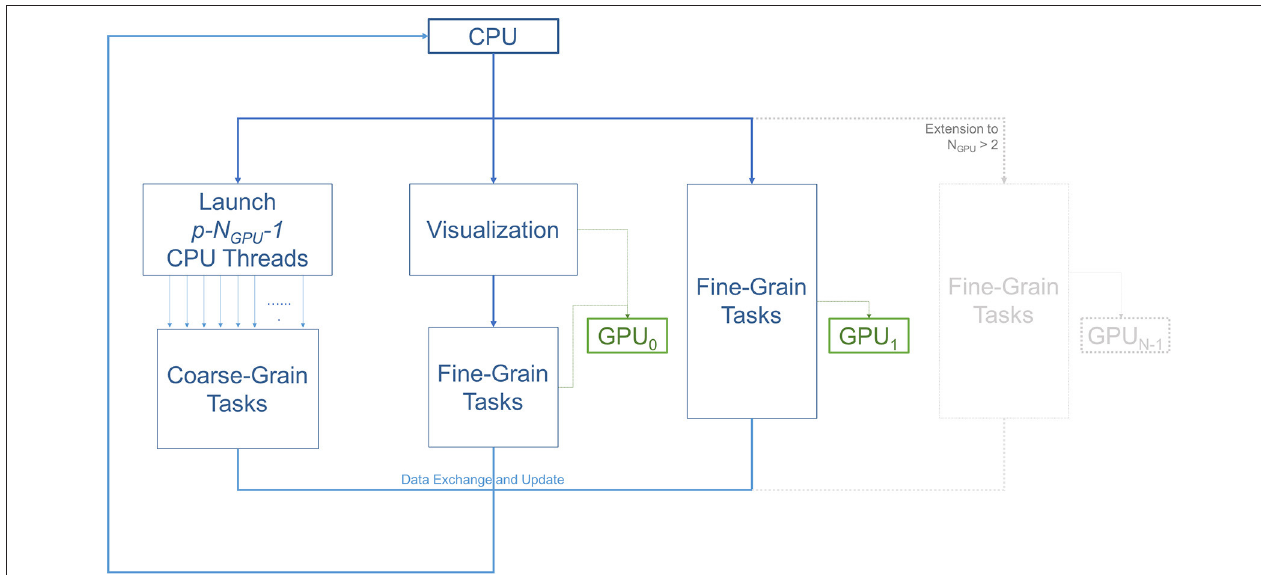
FIGURE 2 | Diagram illustrating the workflow of the three main types of tasks; coarse-grain (CPU), fine-grain (GPU), and visualization. The number of GPUs is two in this setup. However, this scheme can be extended to use more GPUs as demonstrated in the gray part of the diagram. One of the GPUs is used for diffusion (fine-grain tasks), while the other is used for both visualization and diffusion. With p available CPU cores, p − N GPU − 1 or p − 3 threads are allocated for coarse-grain functions. The other N GPU threads are in charge of managing data transfers and dispatching fine-grain tasks to the GPUs, and the last thread is spared for visualization.